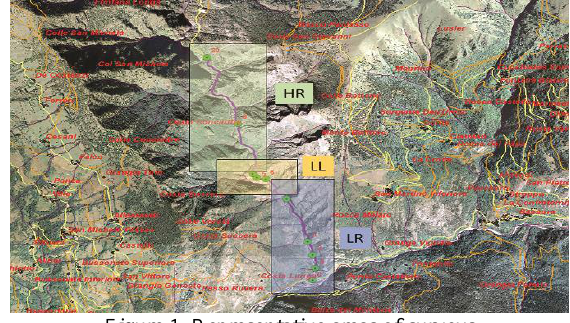
Figure 1. Representative areas of